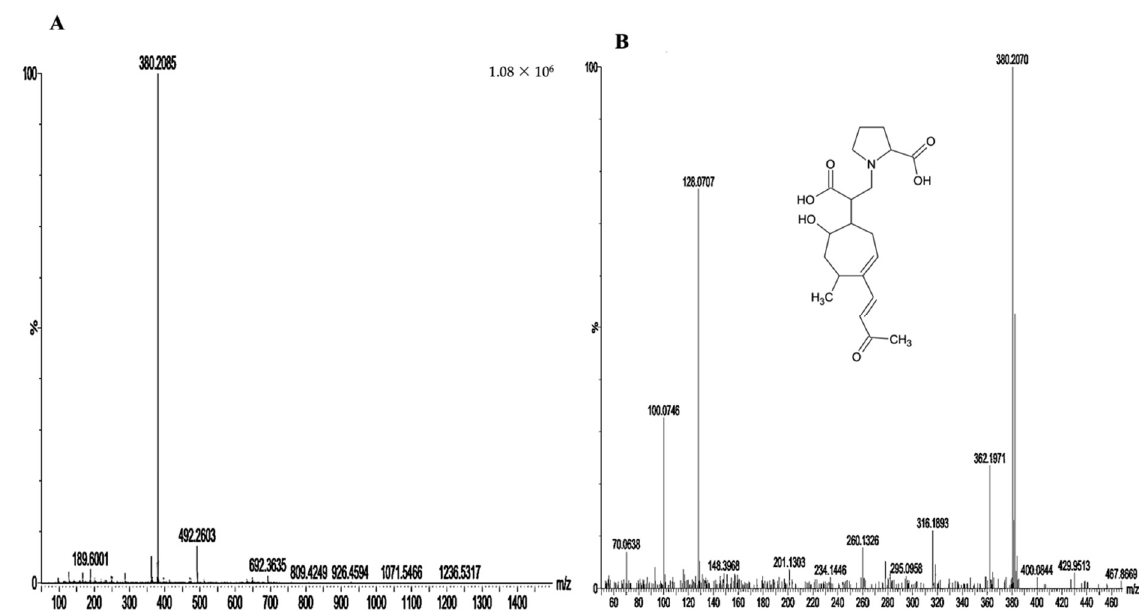
Figure 3. Chemical analysis of the G32 fraction and isolation of the peak of m / z 380 [M + H] + molecule: ( A ) MS spectra at 3.2 min in G32 fraction; ( B ) MSMS spectra of ion m / z = 380 [M + H] + .